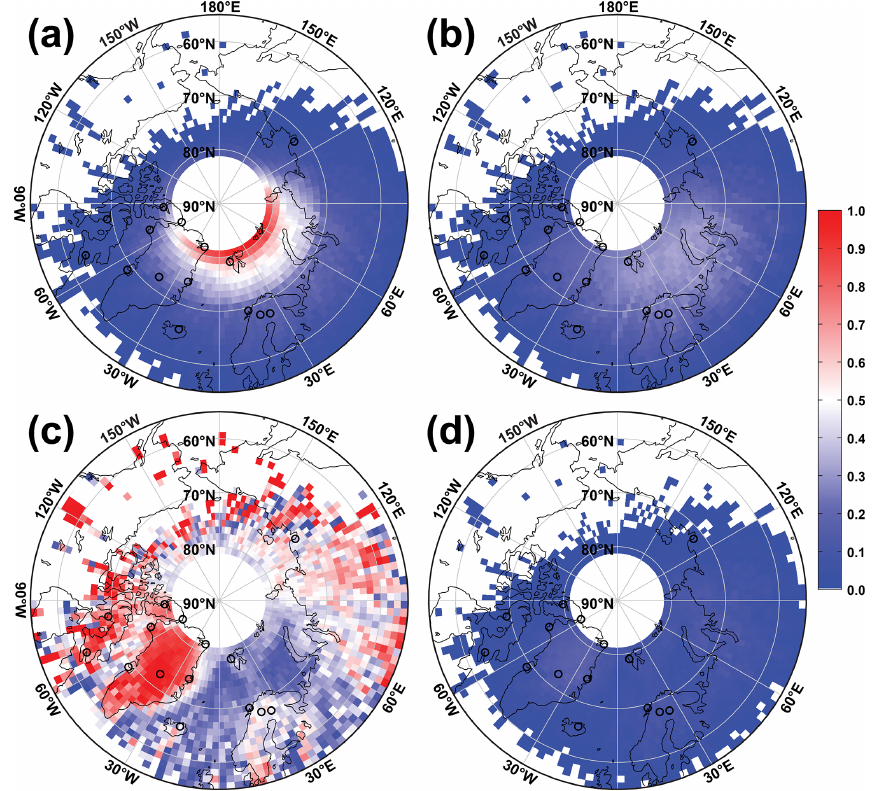
Figure 2. Normalised number of CALIPSO profiles with PSCs detected over the Arctic ( a , scaled to maximum count of 2478), ratio of CALIPSO profiles with PSCs detected versus all CALIPSO profiles (with and without PSCs detected) for the same time period ( b , PSC occurrence rate), ratio of CALIPSO profiles with favourable tropospheric cloud conditions for ground-based lidar measurements (no or only transparent clouds) and PSCs detected versus all CALIPSO profiles with PSCs detected for the same time period (c) , and ratio of CALIPSO profiles with favourable tropospheric cloud conditions for ground-based lidar measurements and PSCs detected versus all CALIPSO profiles for the same time period (d) . Black circles mark the locations of lidar ground stations shown in Fig. 1 and listed in Table